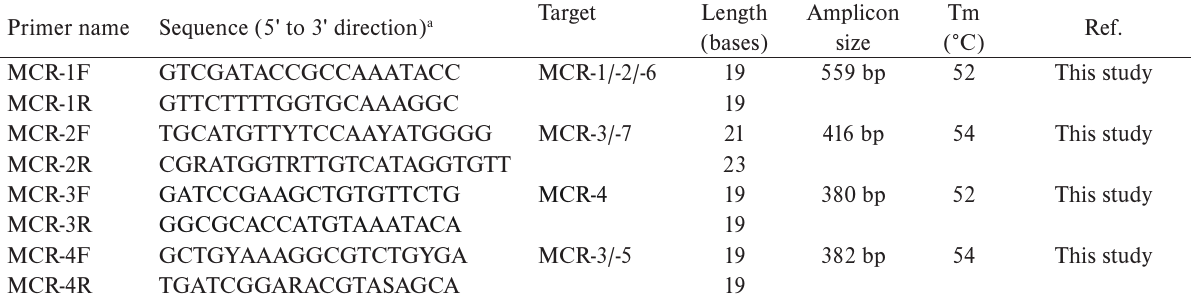
Table 1. Sequences of primers used for PCR for detection of mcr genes and their variants. Primer